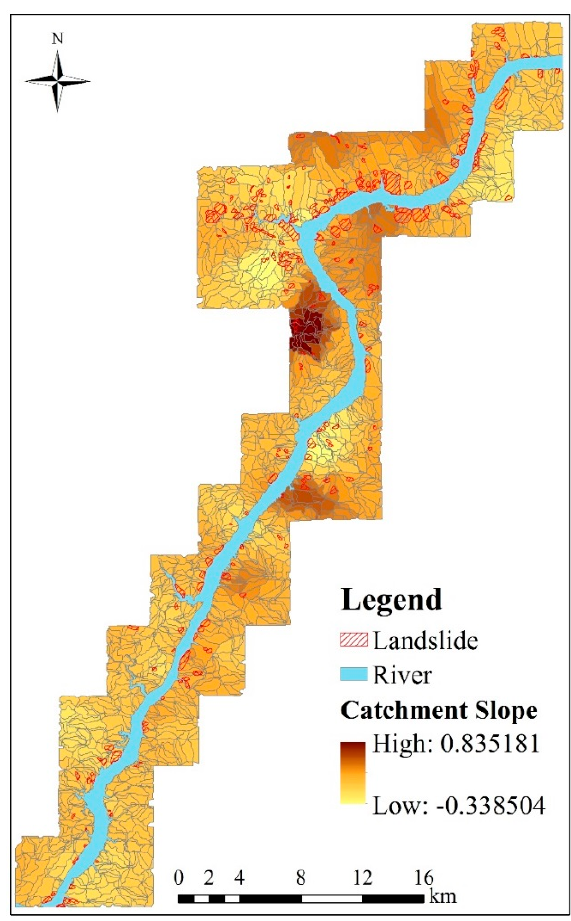
Figure 11. The GWR coefficient map of the catchment slope.